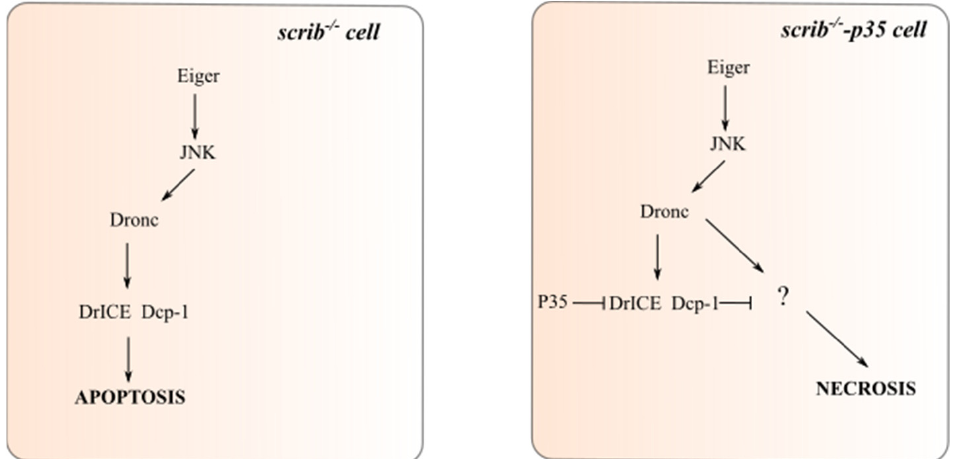
Figure 2. Necrosis functions as an apoptosis fail-safe mechanism in preventing tumour development. Scrib mutant ( scrib -/- ) cells are removed from the epithelial tissue via Egr/JNK-induced apoptosis to prevent tumourigenesis. When apoptosis is defective or blocked, e.g., via expression of the executioner caspase inhibitor P35, scrib -/- cells instead undergo Dronc-mediated necrosis. How Dronc activates necrosis is not yet known, indicated by the question mark.